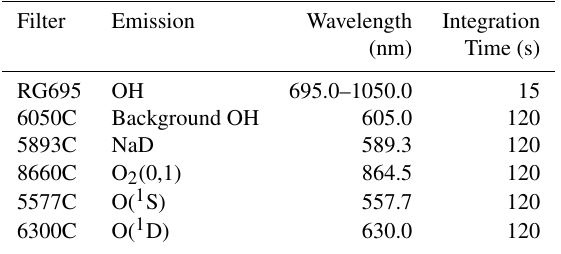
Table 1. Configuration of the all-sky imager system used to collect airglow images during the SIMONe–2018 campaign. Airglow im- ages of the campaign are available at http://sirius.bu.edu/data/. NaD represents a sodium atom at the D transition